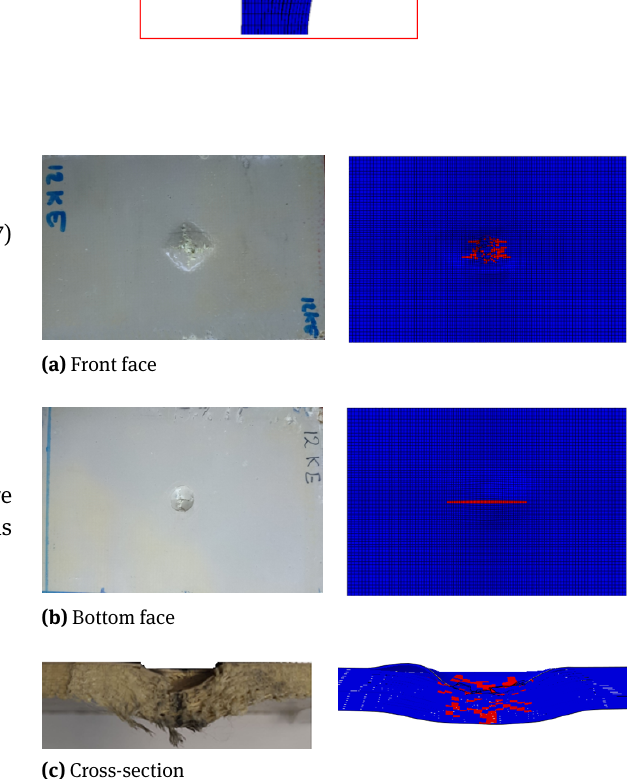
Figure 7: Comparison between experimental numerical damage of Kevlar 12 plies reinforced